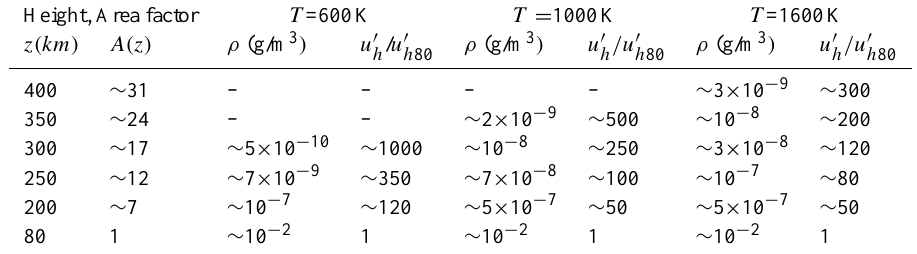
Table 1. Approximate variations with altitude of the area over which momentum fluxes for a specific GW are distributed, A(z) , mean density, ρ(z) , and implied GW horizontal perturbation velocity for thermospheric temperatures of 600, 1000, and 1600K. We have assumed no dissipation for the estimates in this table, and no data are provided for altitudes above those to which GWs are expected to penetrate. Height, Area factor T =600K T = 1000K